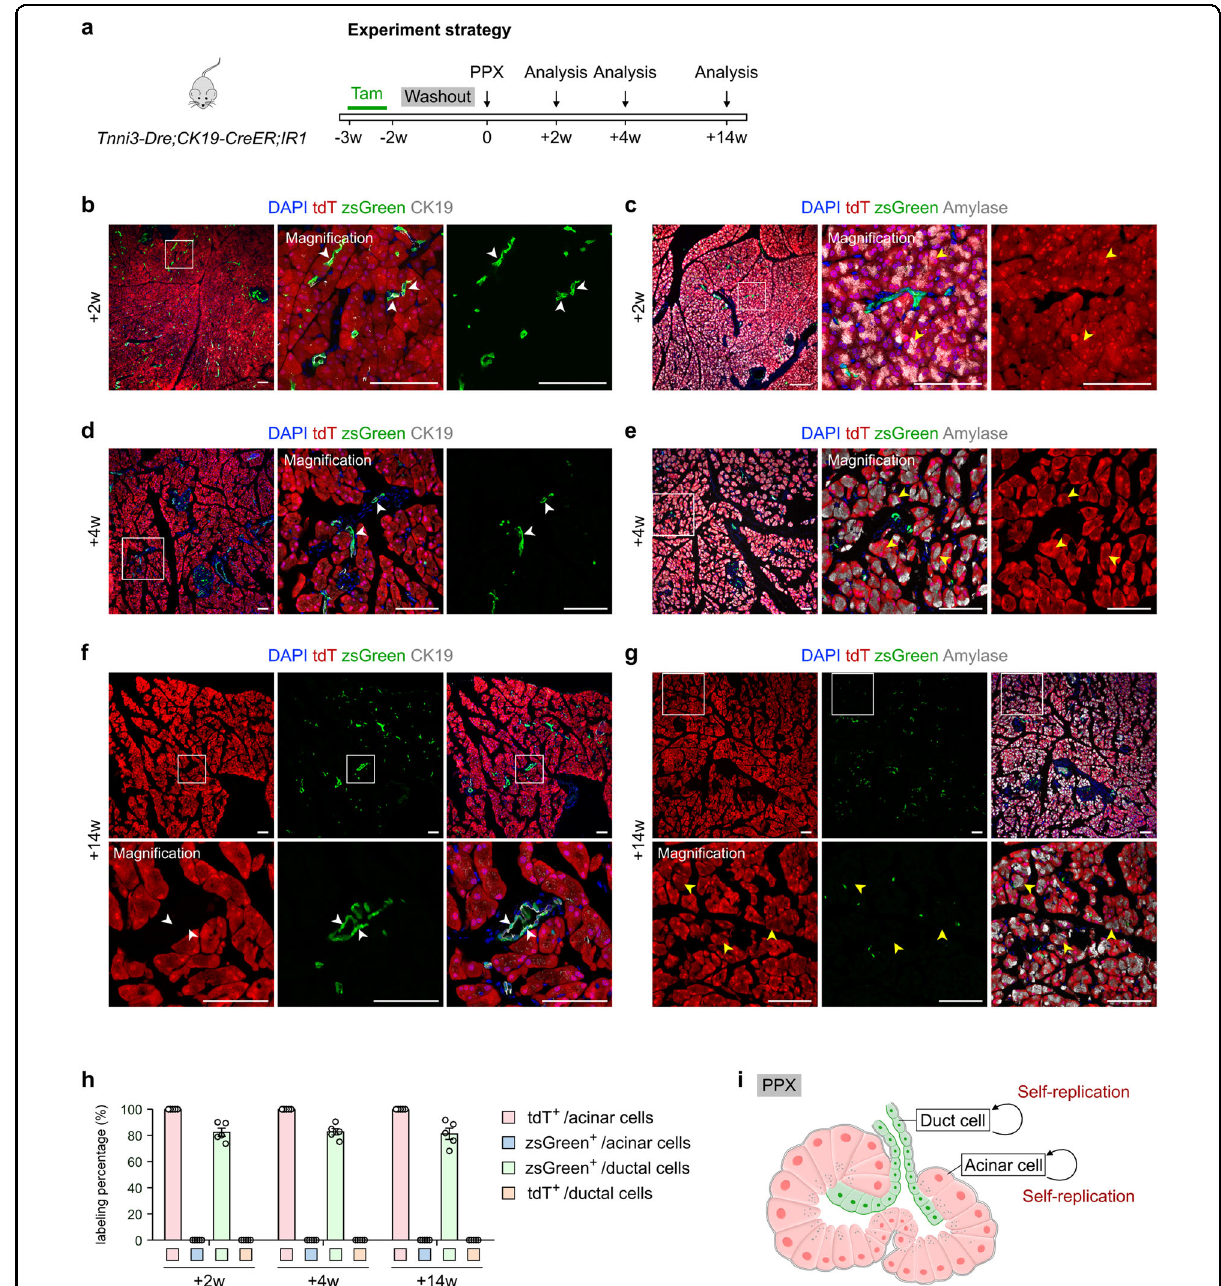
Fig. 4 The pancreas does not exhibit lineage transdifferentiation between exocrine lineages after PPX. a Schematic diagram illustrating the experimental strategy for Tam induction, PPX injury and analysis. b – g Immunostaining for tdT, zsGreen and CK19 ( b , d , f ) or Amylase ( c , e , g ) on pancreatic sections collected from Tnni3-Dre;CK19-CreER;IR1 mice at indicated time points. White arrowheads, zsGreen + ductal cells. Yellow arrowheads, tdT + acinar cells. h Quanti fi cation of the percentage of duct cells expressing zsGreen or tdT and acinar cells expressing tdT or zsGreen from Tnni3-Dre;CK19-CreER;IR1 mice after PPX-induced injury. Data are means ± SEM; n = 5. i Diagram illustrating that pancreatic ductal and acinar cells do not exhibit lineage transdifferentiation after PPX. Scale bars, 100 μ m. Each image is representative of 5 individual